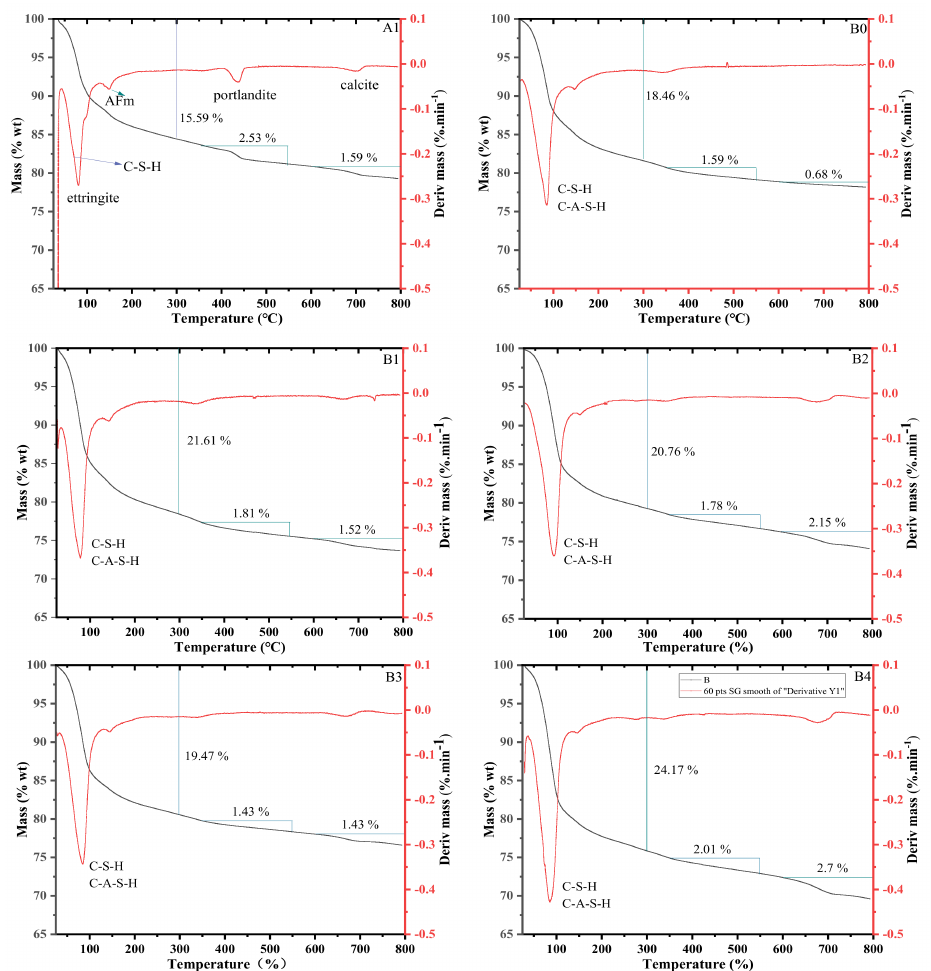
Figure 11. Thermogravimetric curves of the different RCP contents in series A and